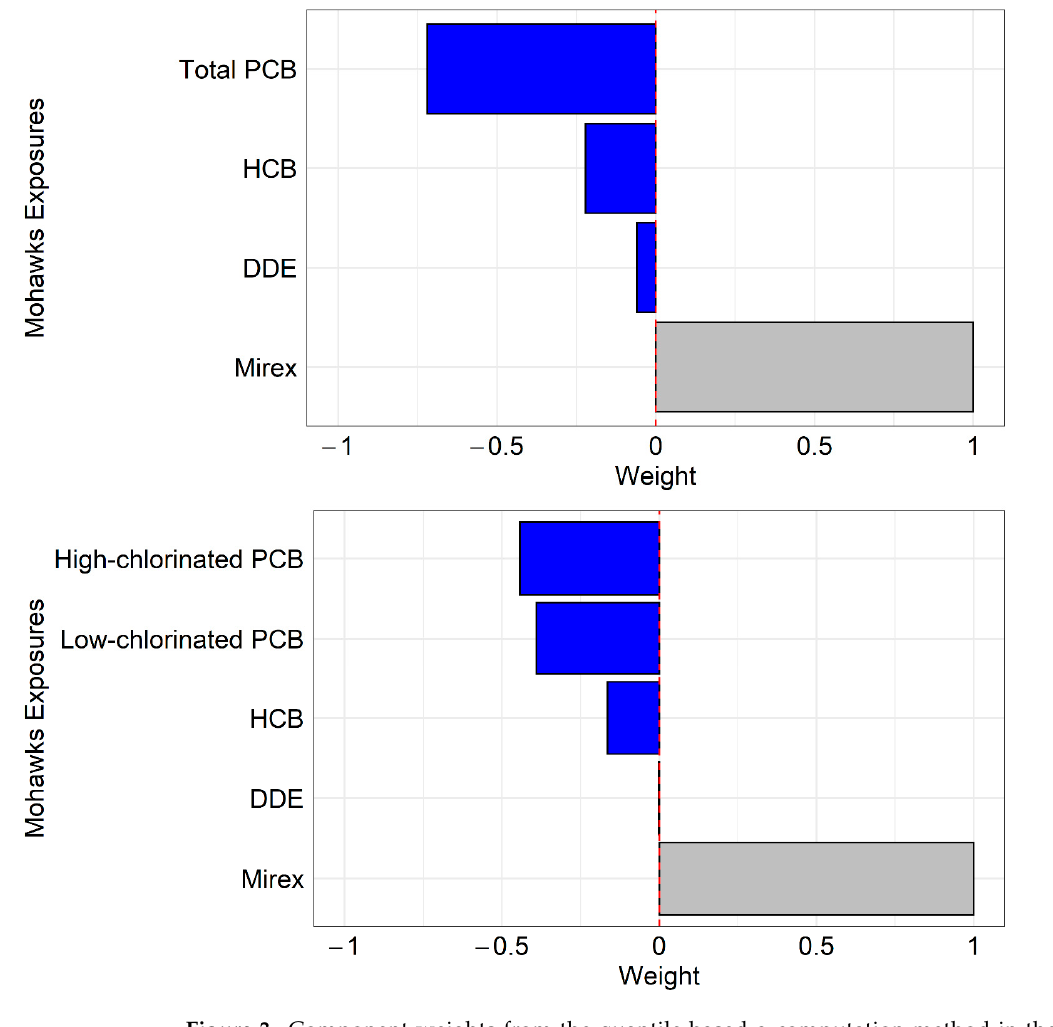
Figure 3. Component weights from the quantile-based g-computation method in the oldest age group. The top figure is from the mixture model with total PCBs, HCB, DDE, and mirex. The bottom figure is from the mixture model with low-chlorinated PCBs, high-chlorinated PCBs, HCB, DDE, and mirex. Models were adjusted for sex and education levels. Significant component weights are shown in blue, and nonsignificant components are shown in gray.